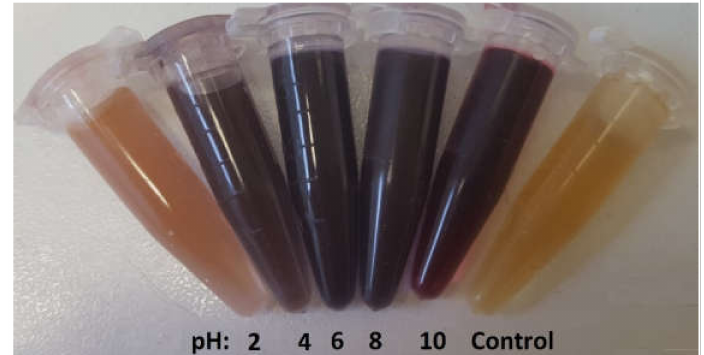
Figure 1. Color changes of mycelium-free supernatant in response to different pH